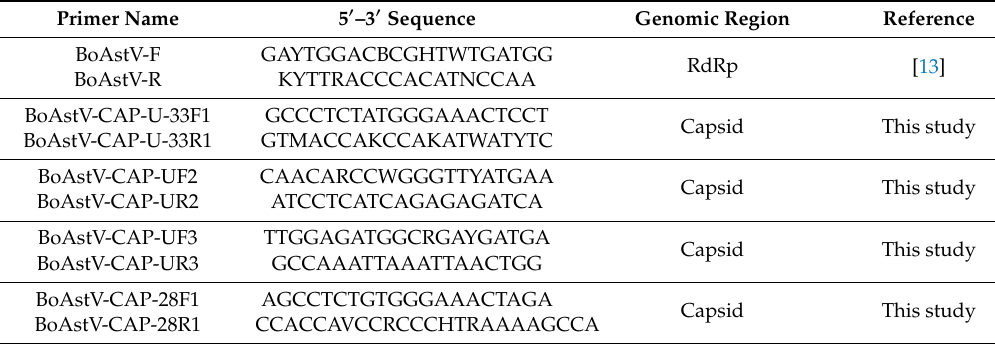
Table 1. Primers used for complete capsid